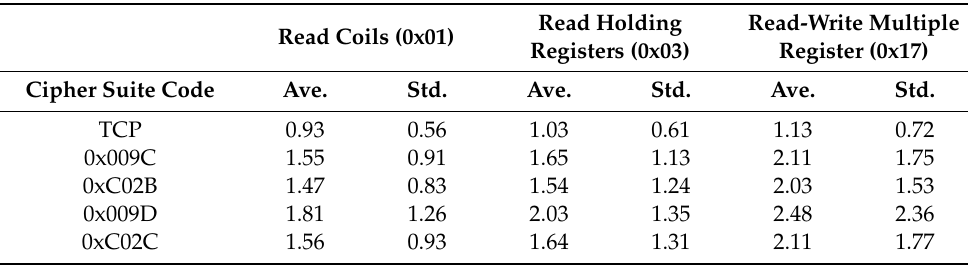
Table 7. Average latencies (ms) and standard deviation in Galois / Counter Mode (GCM) cipher mode (without RBAC model).